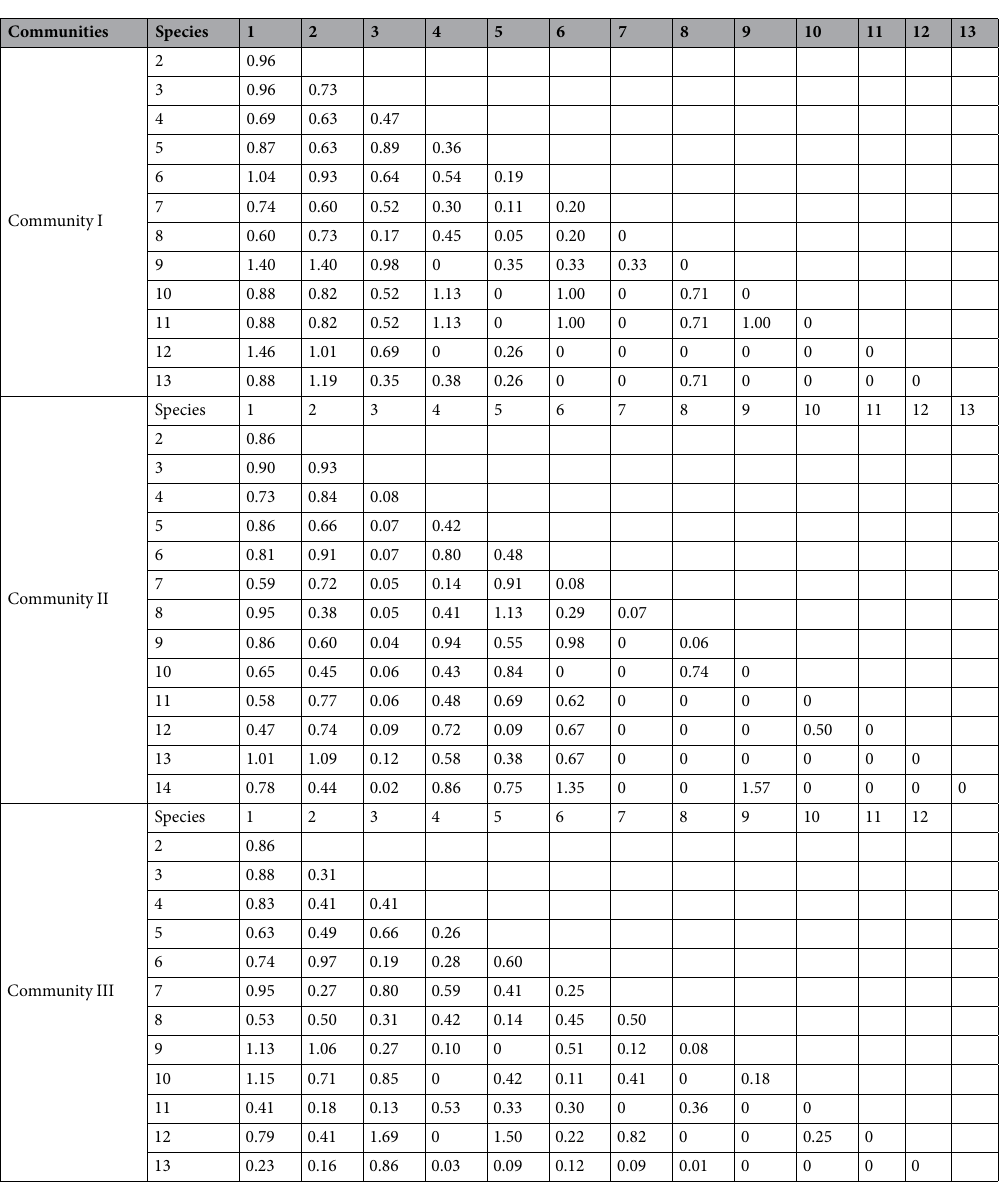
Table 3. Niche overlap of dominant species in different communities. Note: Community I: 1 Pinus tabulaeformis; 2: Quercus wutaishansea; 3: Betula platyphylla; 4: Populus davidiana; 5: Swida macrophylla;